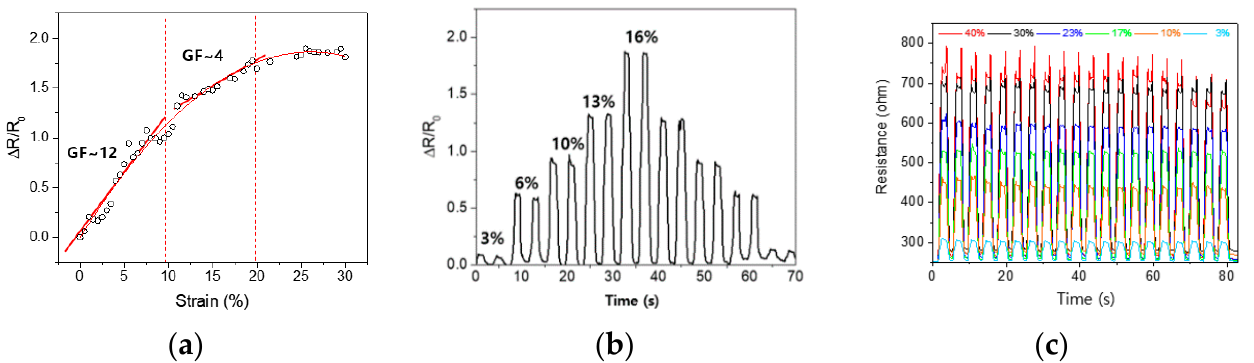
Figure 6. Characterization of the knitted strain sensor, where ( a ) continuous changes up to 30% of strain, ( b ) electrical resistance changes in the stepwise (3%, 6%, 10%, 13%, 16%, 13%, 10%, 6%, 3%) stretching, ( c ) the electrical resistance when cyclic strains are applied at a level of 3%–40% for 20 cy- cles.